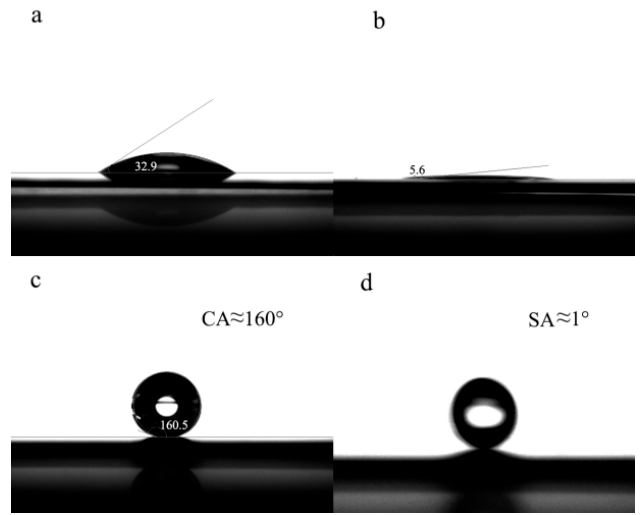
Figure 2. The contact angle (CA) images of ( a ) bare aluminum alloy; ( b ) electrodeposited Ni–Co plating; ( c ) superhydrophobic surface; ( d ) snapshot photograph of a water droplet rolling off on the tilted superhydrophobic surface.